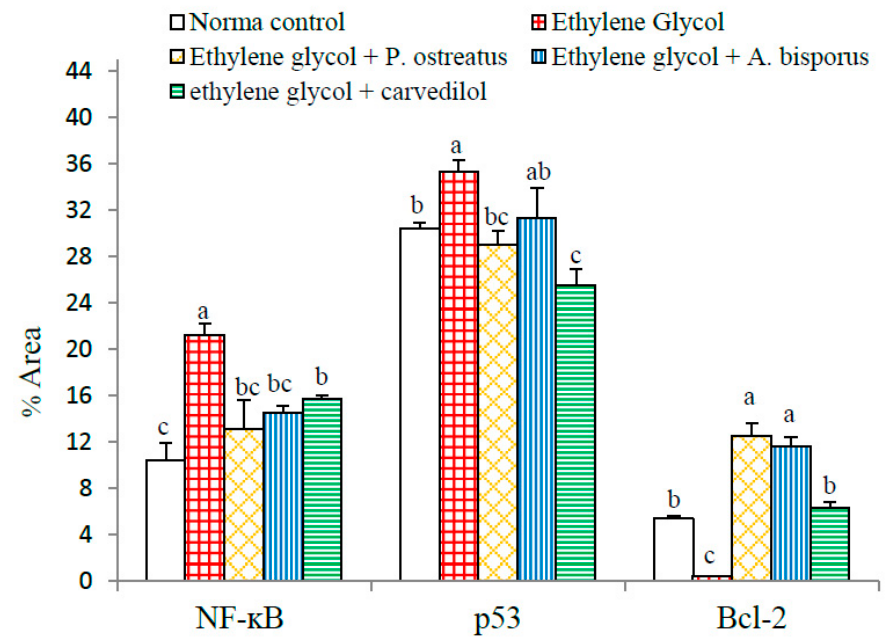
Figure 20. Effect of P. ostreatus and A. bisporus aqueous extracts and carvedilol on percent area of yellowish brown color of NF- κ B, p53 and Bcl-2 expressions detected by image analysis of immunohistochemically stained kidney sections in ethylene glycol-administered rats. For each mediator, three kidney sections from three rats of each group were immunohistochemically stained and were subjected to ImageJ analysis. For each parameter, means which share the same superscript letter(s) are not significantly different.